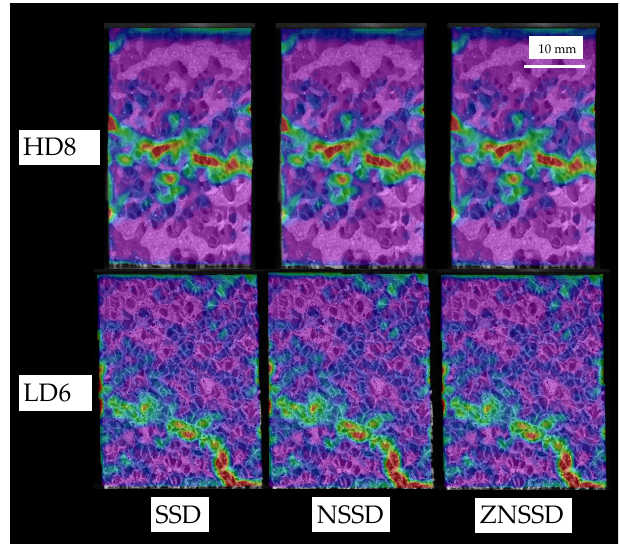
Figure 11. Equivalent strain distribution for a high-density (HD) specimen ( top ) and a low-density (LD) specimen ( bottom ), for sum of squared differences (SSD) ( left ), normalized squared differences (NSSD) ( middle ) and zero-normalized squared differences (ZNSSD) pattern matching criterion ( right